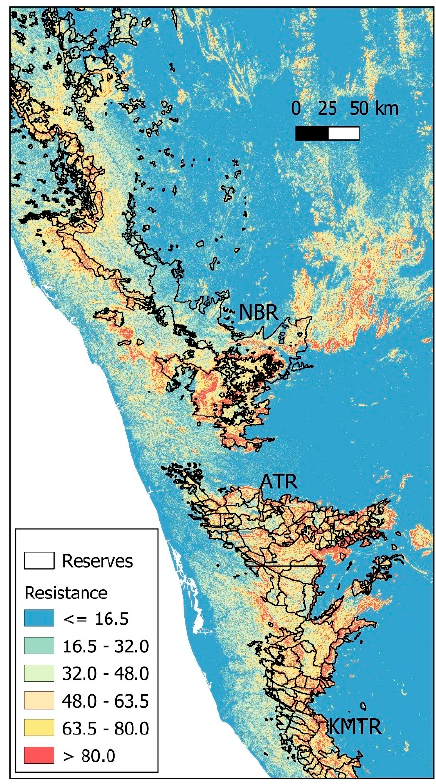
Figure 3. Representation of elephant gene flow resistance over the Western Ghats of India relative to slope (see text for detail). Gene flow resistance would be very high beyond the reserve limits if other factors such as land use had been taken into consideration. Reserve boundaries were obtained from